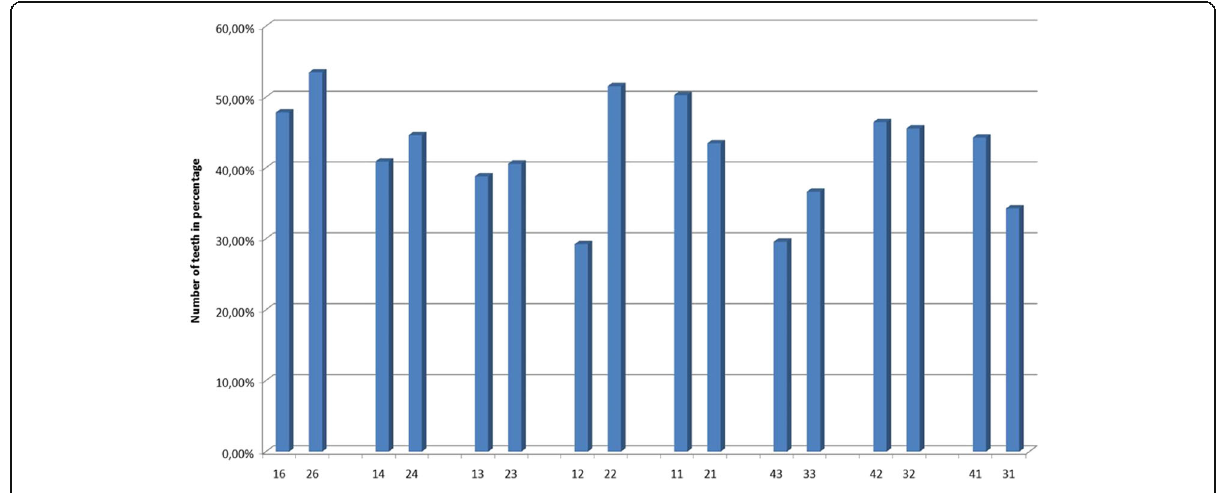
Fig. 3 Percentage of teeth affected by RR (rRCR < 100%)